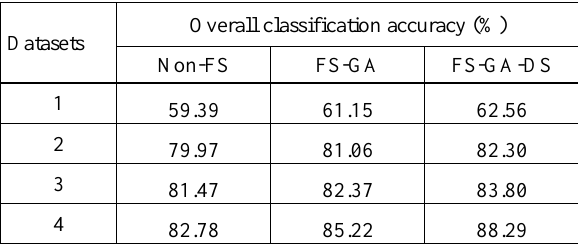
Table 4. Comparison of best classification results using non-FS, FS-GA and FS-GA-DS classifier combination method.